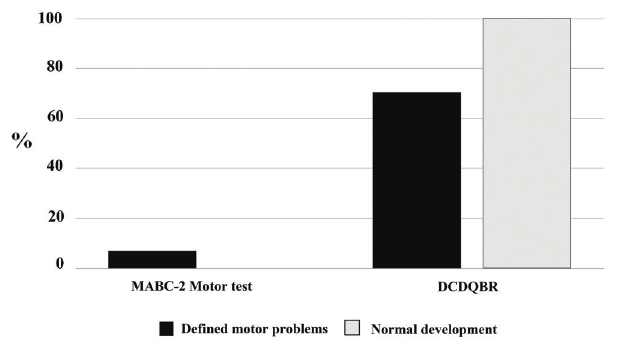
Figure 2. Classification of the children’s motor development using the MABC-2 motor test according to the